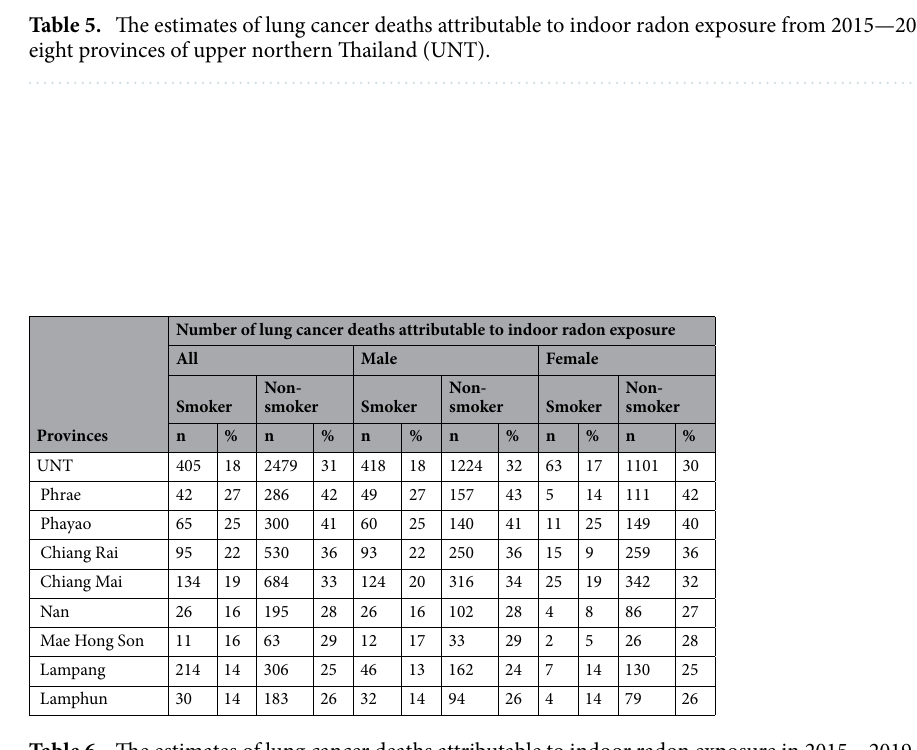
Table 6. The estimates of lung cancer deaths attributable to indoor radon exposure in 2015—2019 for eight provinces of upper northern Thailand (UNT) by gender and smoking status, according to the EAC